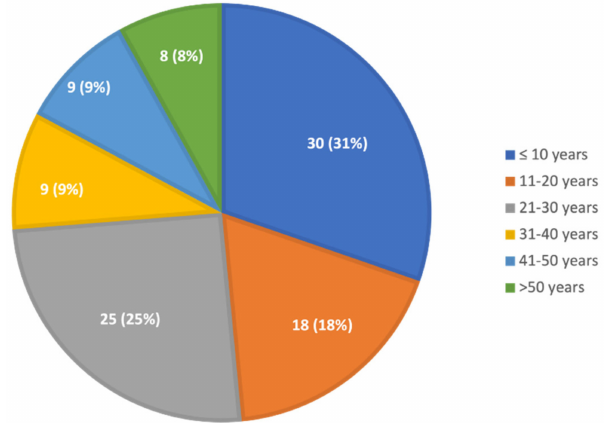
Figure 1. Age at diagnosis of GD. Thirty children were diagnosed at the age of 0–10 years, 18 at